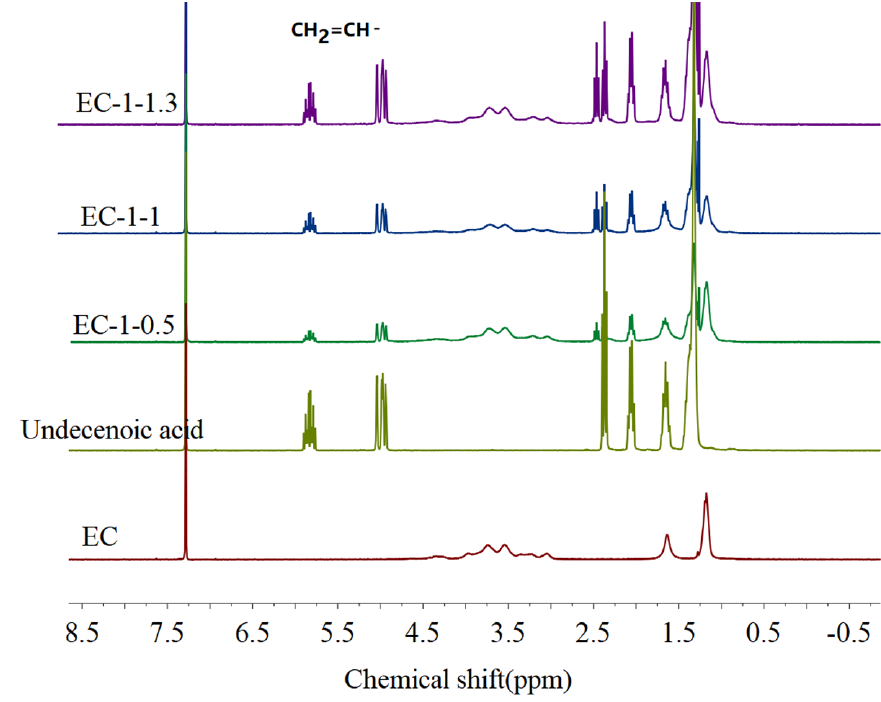
Figure 1. 1 H NMR of OFE, EC and undecenoic acid.